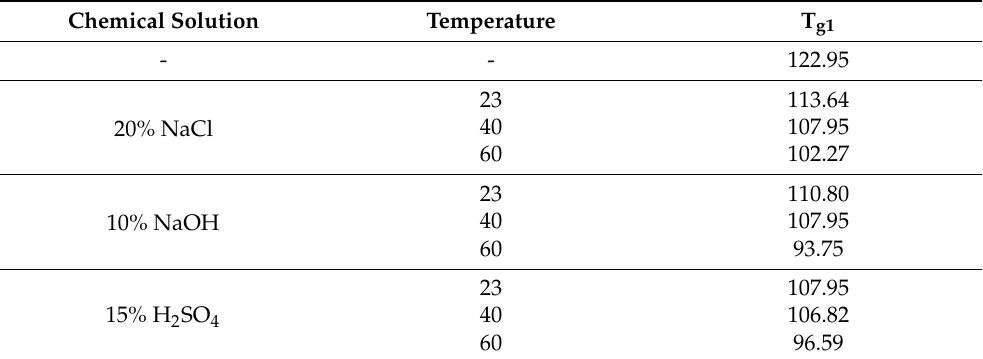
Table 4. The glass transition temperature is determined by the dependence of the complex modulus of elasticity on temperature.